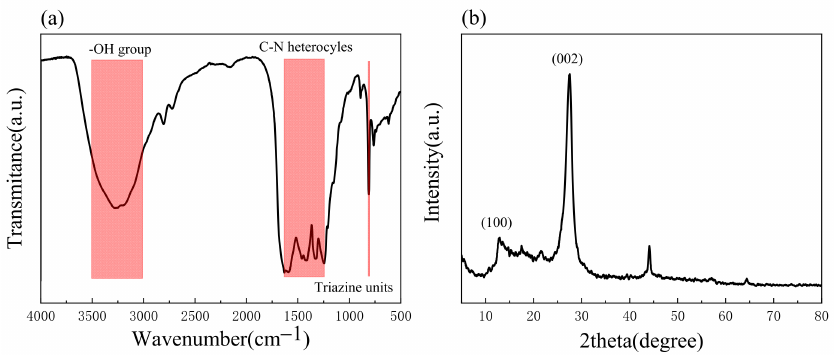
Figure 1. Infrared spectra and X-ray energy spectra of g-C 3 N 4 : ( a ) FT-IR; ( b ) XRD.